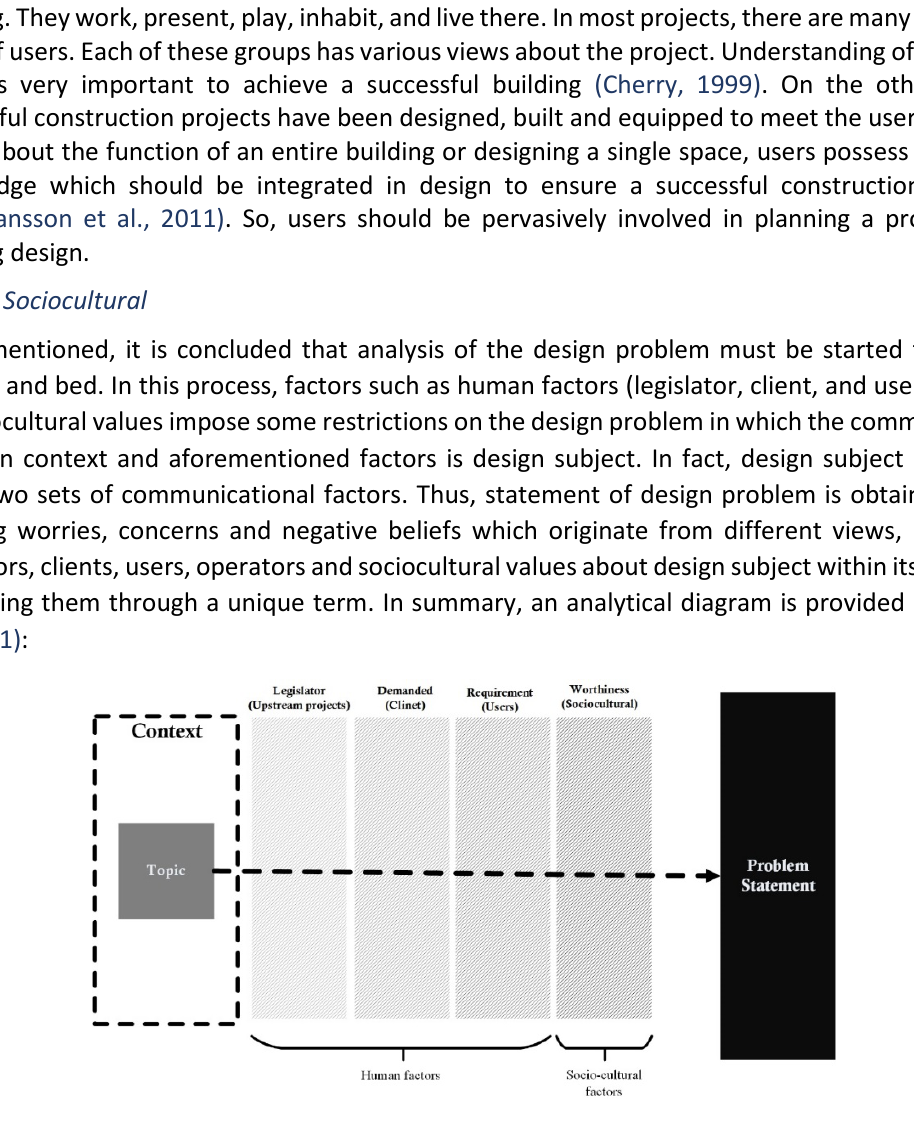
Figure 1 Formulation of design problem